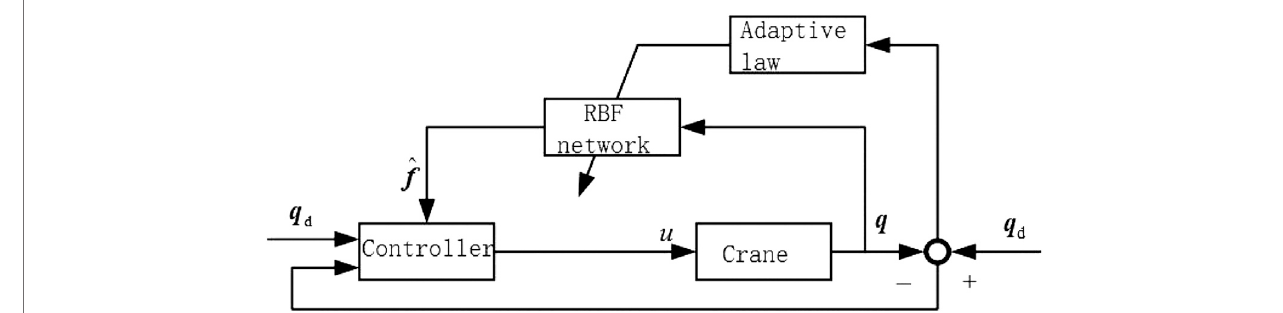
FIGURE 3 | Adaptive control based on neural network compensation.